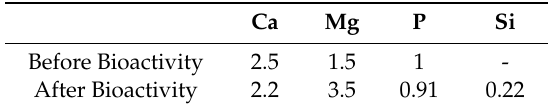
Table 8. Ion concentration of SBF (simulated body fluid) before and after 28 days of sample inmersion. Results in